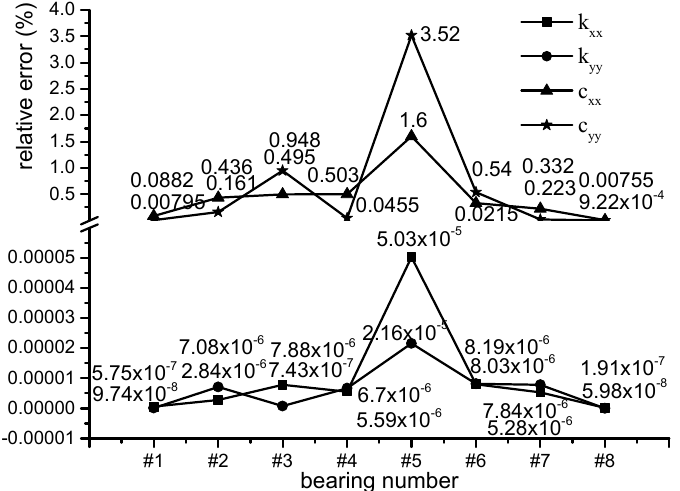
Figure 4. The biggest relative identification error obtained using g4.4 based on Algorithm I. For g4.4, according to Figure 4, the maximum relative errors of k1.xx, k2.xx, . . . ,